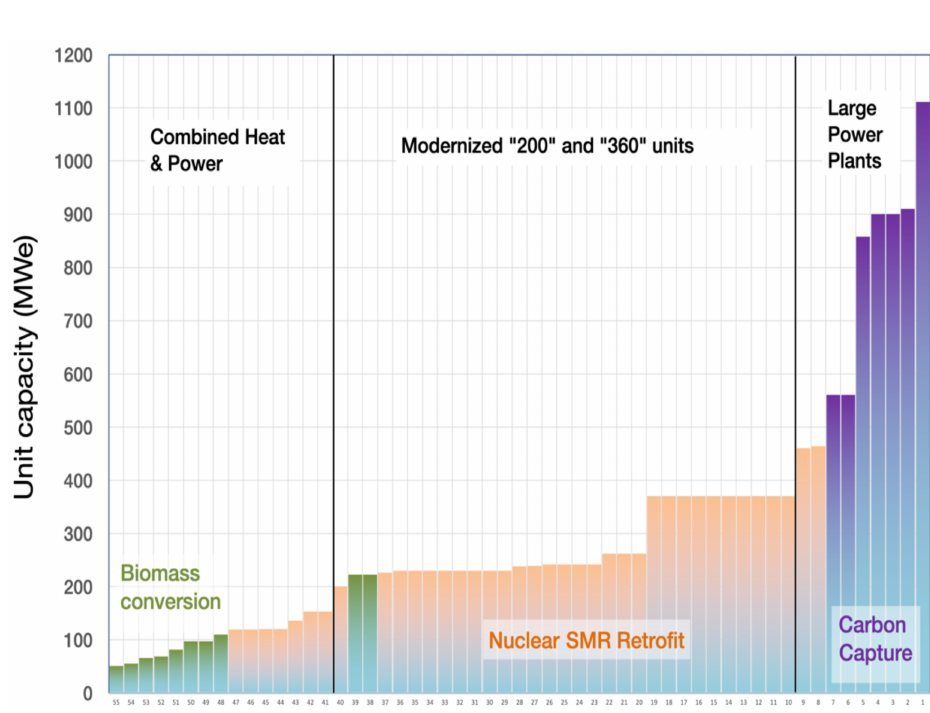
Figure 12. Potential retrofit decarbonization pathways for 55 large and modern or modernized Polish coal